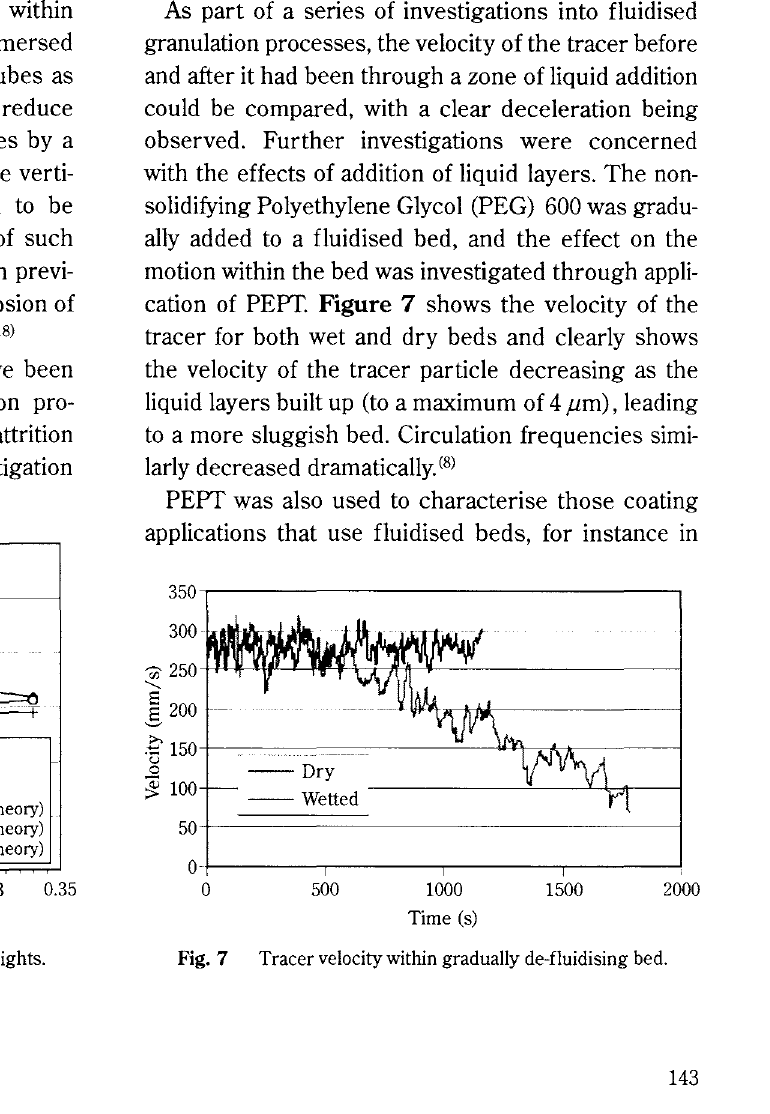
Fig. 6 Circulation frequency for a number of bed heights. Fig. 7 Tracer velocity within gradually de-fluidising